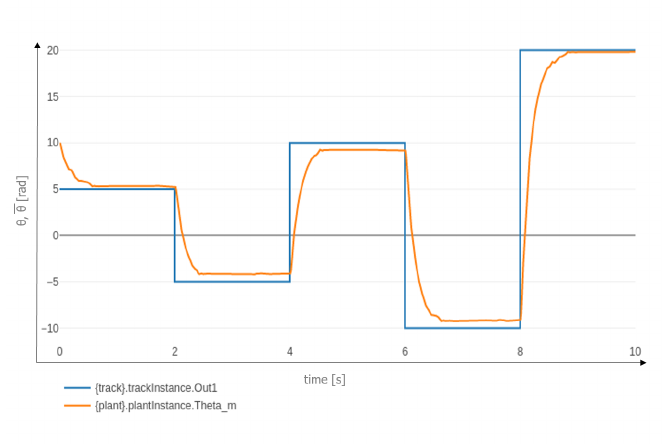
Figure 10. Co-simulation for K 11 = − 1000 and K 22 = −